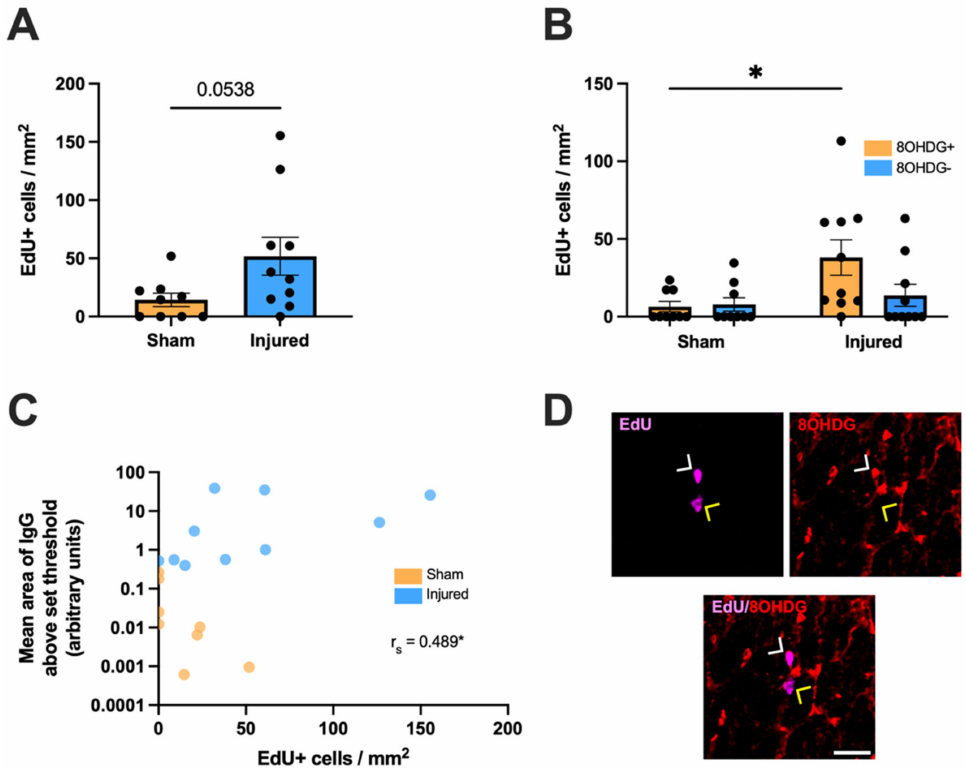
Figure 2. Effect of injury on cellular proliferation within the ventral optic nerve. ( A ) The density of EdU+ cells was quantified in the ventral optic nerve following partial optic nerve transection or sham injury. Graphs display individual data points overlaid on a bar displaying the mean ± SEM. n = 9–10 rats per group. Statistical analysis by t -test. ( B ) The relative densities of EdU+ 8OHDG+ and EdU+ 8OHDG − cells were quantified. Statistical analysis by two-way ANOVA and Tukey post- hoc tests. Graphs display individual data points overlaid on a bar displaying the mean ± SEM. n = 9–10 rats per group. ( C ) The area of IgG immunointensity was correlated to the density of EdU+ cells using Spearman’s correlation, with the r s value and corresponding p -value displayed on the graph. The mean area of IgG immunointensity was plotted on a log scale to best illustrate the overall relationship between IgG and EdU on the scatterplot. Each data point on the graph represents an individual animal. n = 8–10 rats per group. ( D ) Representative image of both an EdU+ 8OHDG+ cell (white arrow head) and an EdU+ 8OHDG − cell (yellow arrow head) is shown, scale bar = 25 µ m. No outliers were removed for any outcome measure. Significant differences are indicated by * p ≤